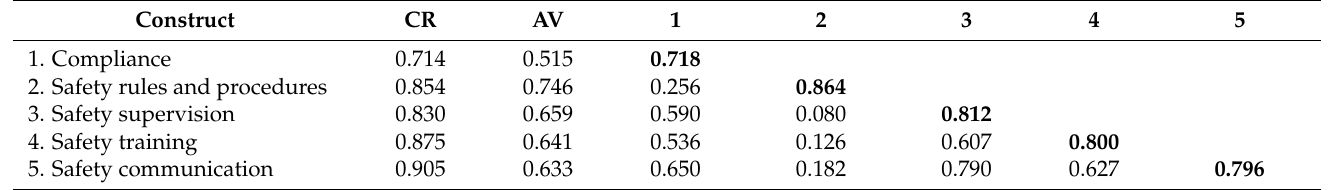
Table 2. Inter-construct correlations, convergent, and discriminant